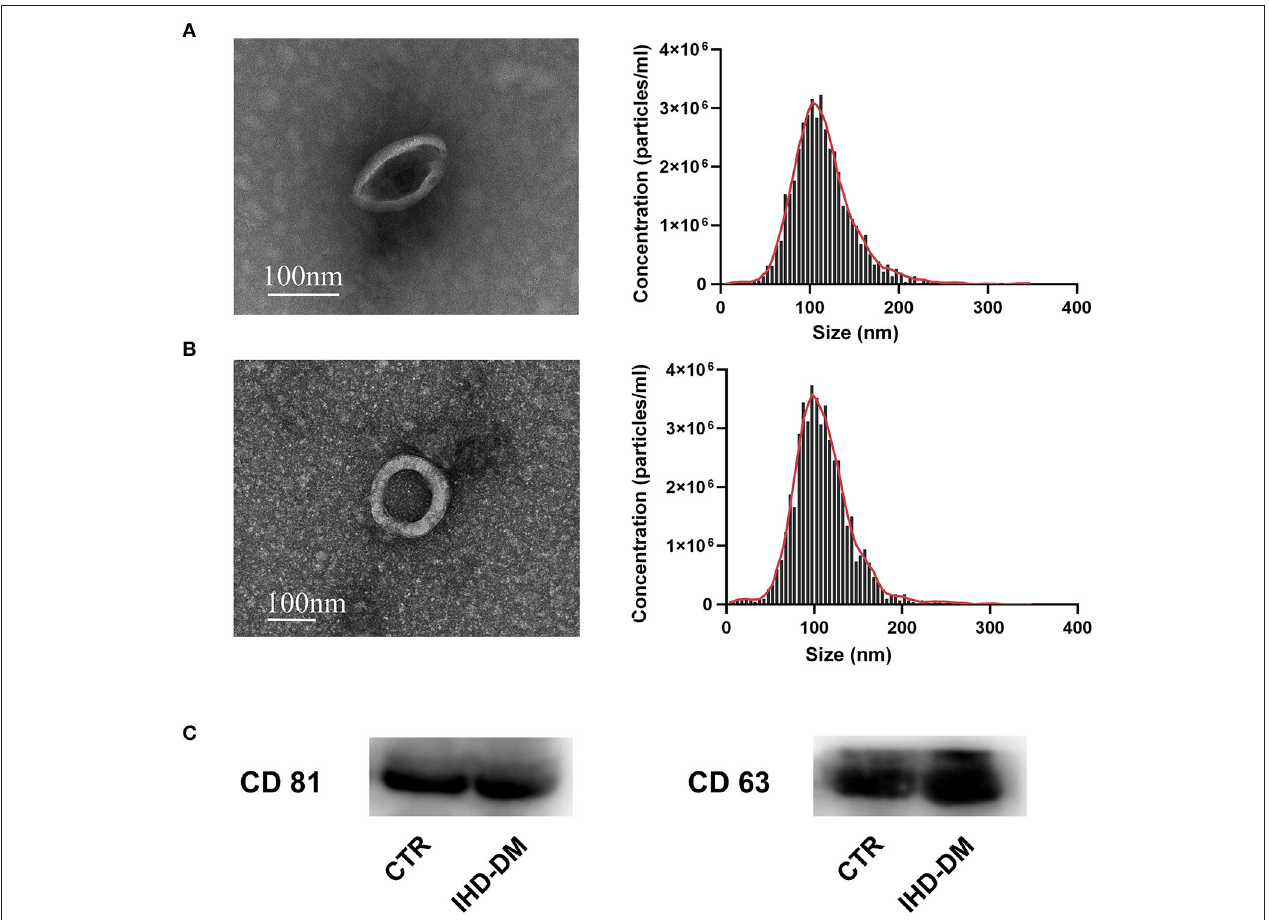
FIGURE 1 | Human sourced plasma-derived EVs were collected and characterized. (A) Representative transmission electron microscopy (TEM) images and the nanoparticle tracking analysis (NTA) of plasma-derived EVs from healthy controls. (B) Representative TEM and NTA of plasma-derived EVs from IHD-DM patients. (C) Representative immunoblot images show enrichment of EV/exosomal markers CD63 and CD81 in plasma-derived EVs. IHD-DM: ischemic heart disease patients with diabetes mellitus; CTR: healthy